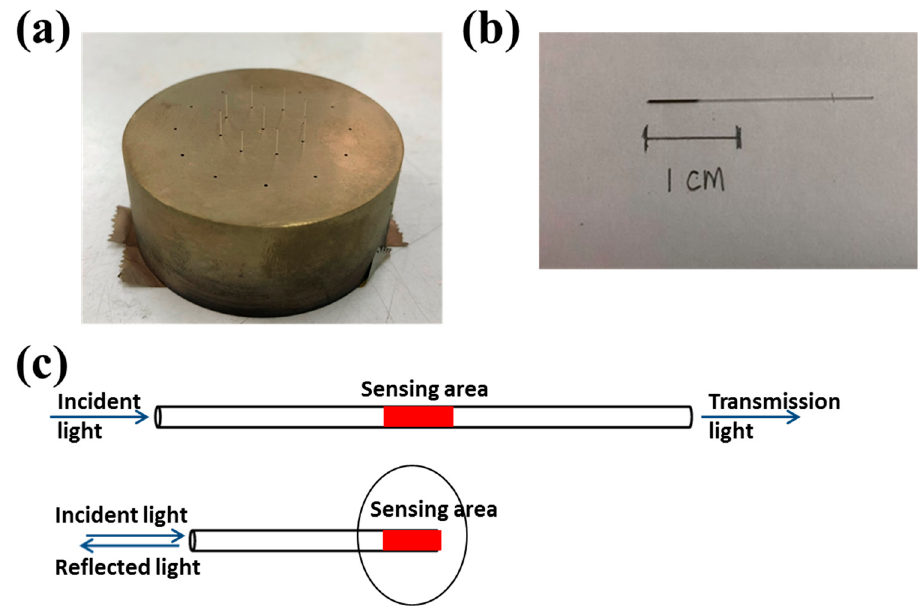
Figure 2. ( a ) The customized sample holder for Au sputtering, ( b ) the bare optical fiber coated with the Au film, ( c ) the sensing areas in most of the D-shaped and D-type OFSs (top) and the present OFS (bottom).